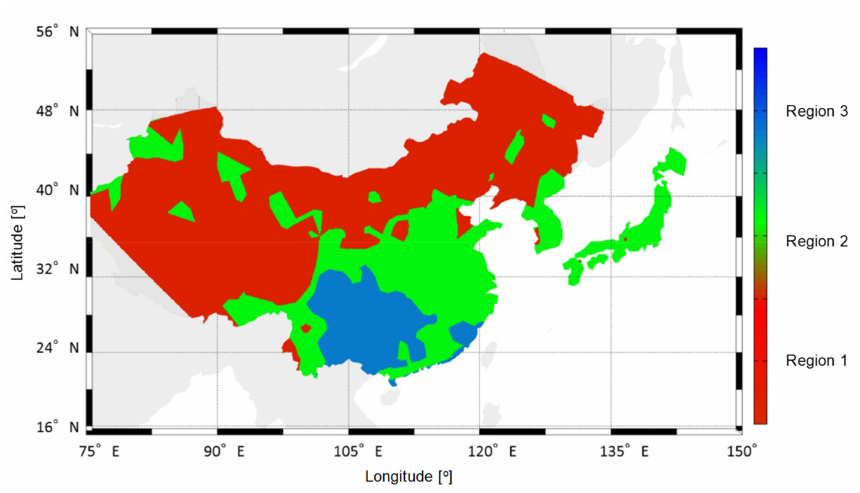
Figure 9. Classification by solar-heat available days (based on Table 13).